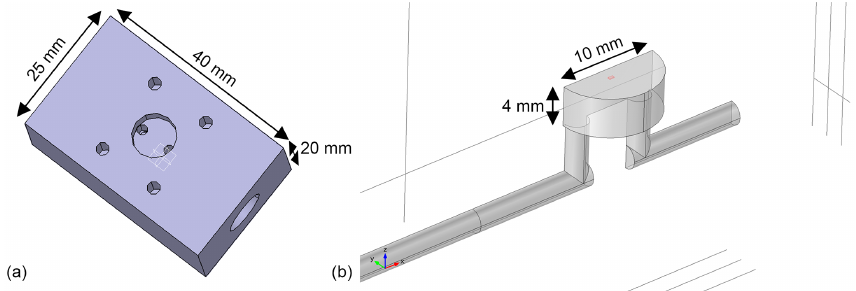
Figure 4. Sensor chamber with low dead volumes and short diffusion paths from the carrier gas flow to the sensor surface for fast and sensitive peak detection. (a) CAD model showing the side where the sensor is mounted and fixed with screws. (b) 3-D model (cut in half due to symmetry) of the gas path used for simulations; the position and size of the gas-sensitive layer (500 × 500µm 2 ) are marked in red.